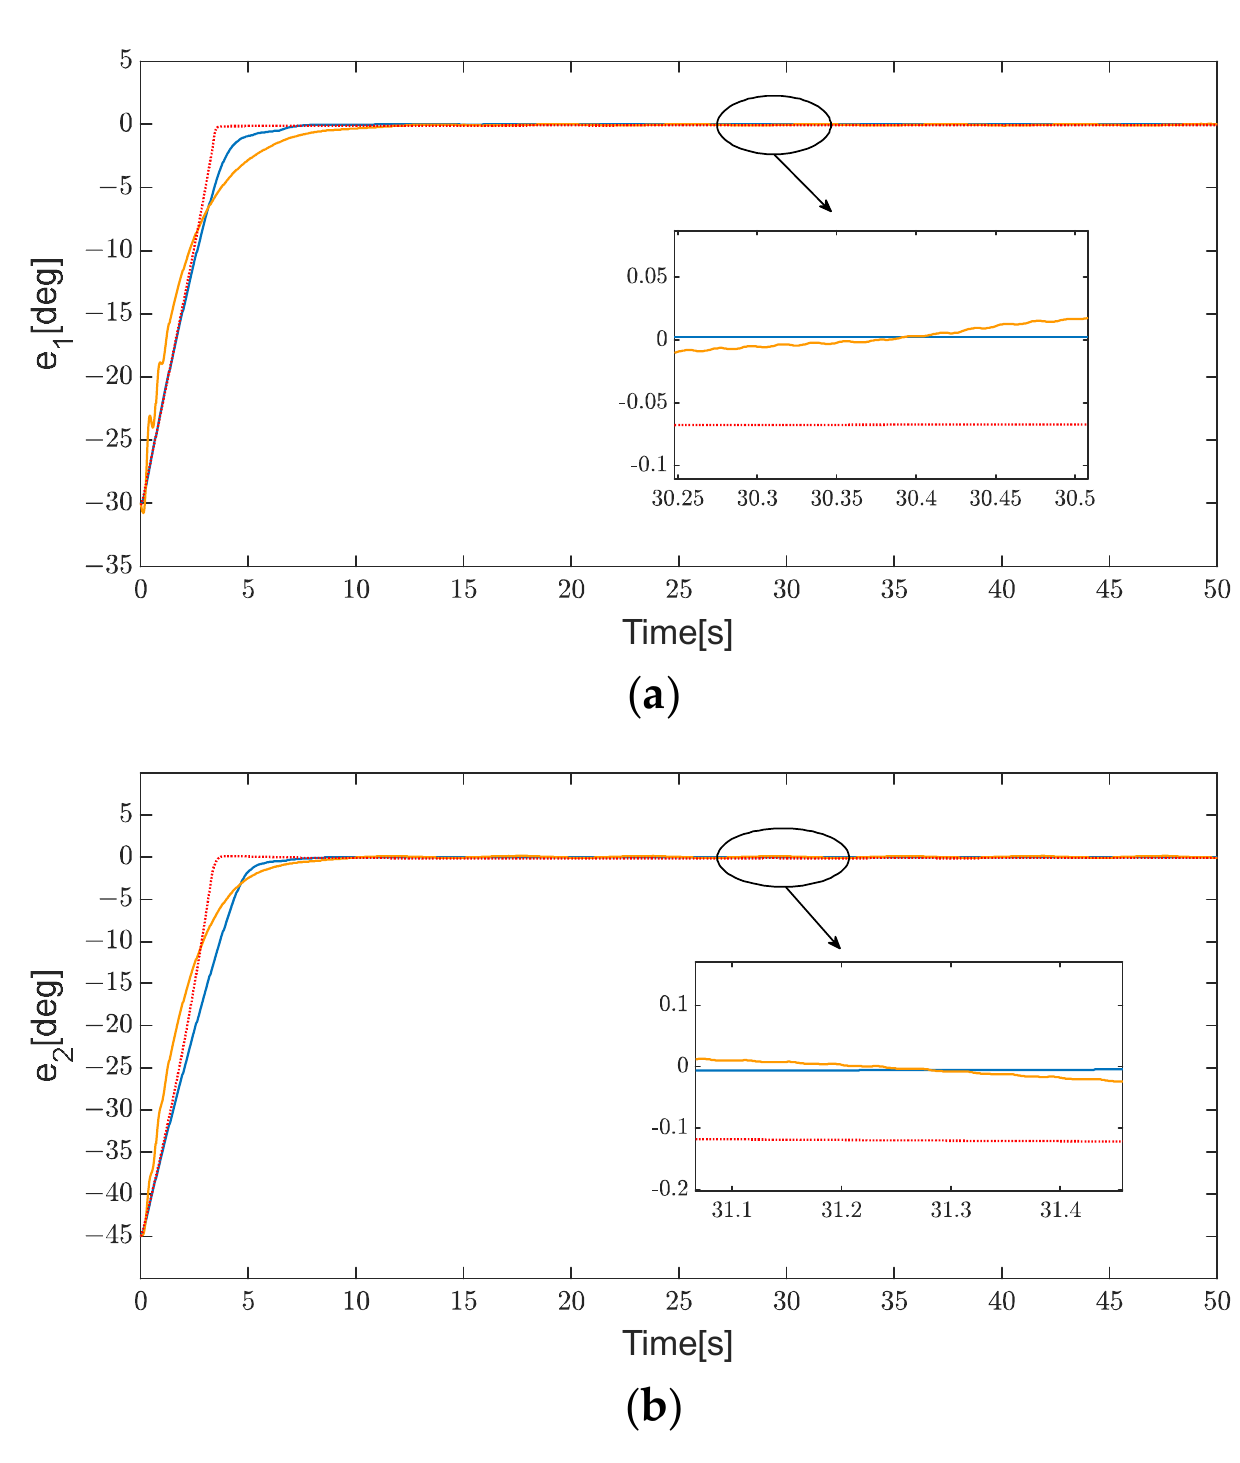
Figure 12. Comparison of angular position error to [43,44] in case 2: the [43] scheme (yellow solid line), the [44] scheme (red dash line), the proposed scheme (blue solid line); ( a ) Joint 1. ( b ) Joint 2.